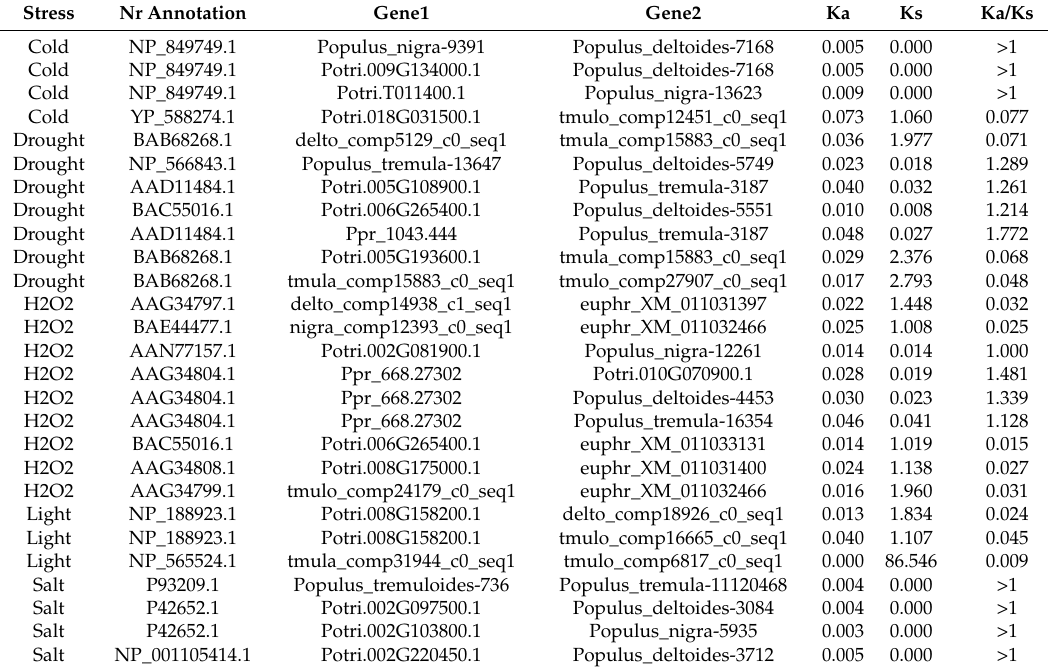
Table 4. Information of resistance genes involved in positive selection in genus Populus